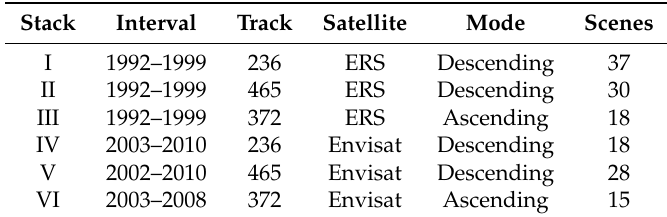
Table 1. The six distinct interferometric stacks processed, consisting of ERS-1/-2 and Envisat, descending and ascending tracks, for the 1992–2010 time span.